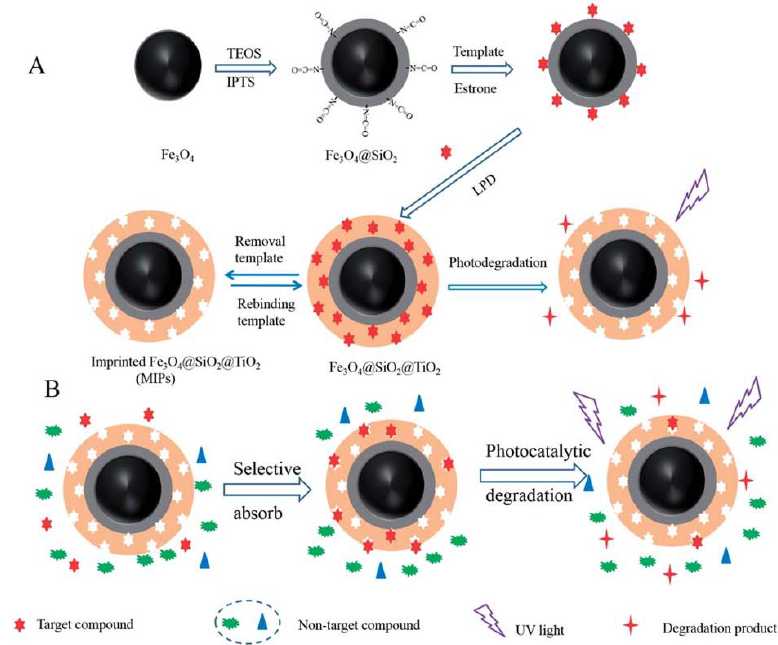
Figure 7. The Schematic illustrations for preparation estrone imprinted TiO 2 films on the surface of magnetic Fe 3 O 4 nanoparticles ( A ) and the possible mechanism of selective photocatalyst degradation of target template by imprinted Fe 3 O 4 @SiO 2 @TiO 2 ( B ). Reprinted with permission from ref [62]. Copyright 2014 American Chemical Society.